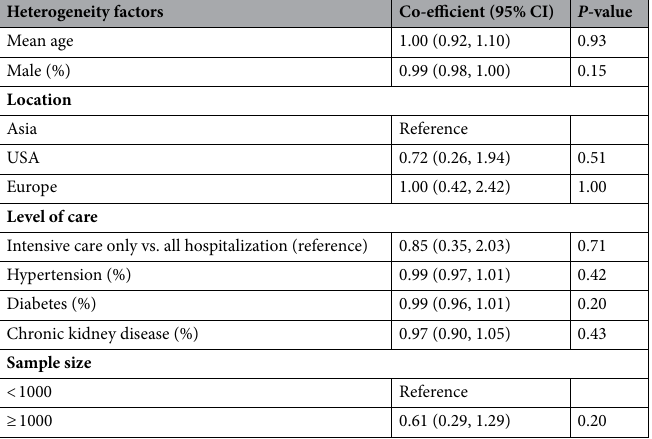
Table 2. Univariate meta-regression of possible sources of heterogeneity across the included